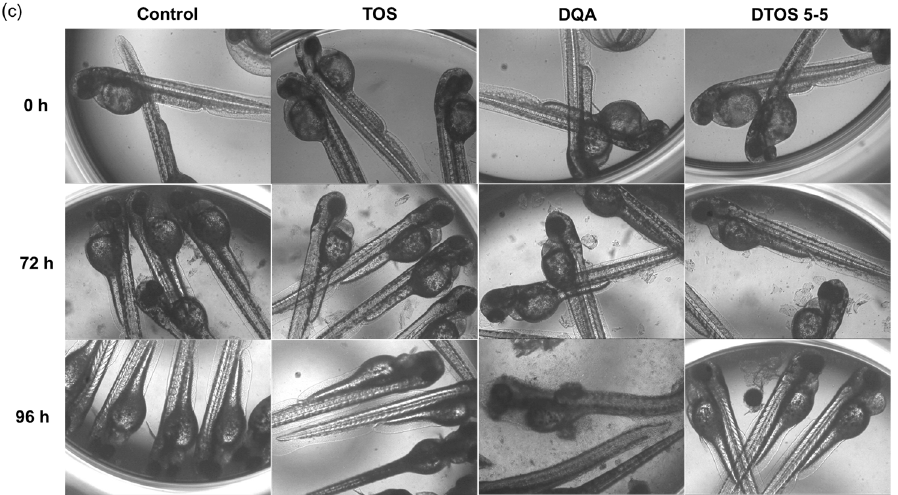
Figure 10. Evaluation of the in vivo toxicity of dequalinium (DQA) and α -tocopherol succinate ( α - TOS) (DTOS) emulsions in zebrafish larvae. ( a ) The survival ratio of zebrafish larvae after treatment with various concentrations of samples at 72 and 96 hpi. Each value represents the average and standard deviation (n = 3). ( b ) The survival ratio of zebrafish larvae after treatment with 30 μ M at a certain time. Each value represents the average and standard deviation (n = 3). ( c ) The morphology of the embryos after treatment with 30 μ M of samples at a certain time. hpf, hours post-fertilization.